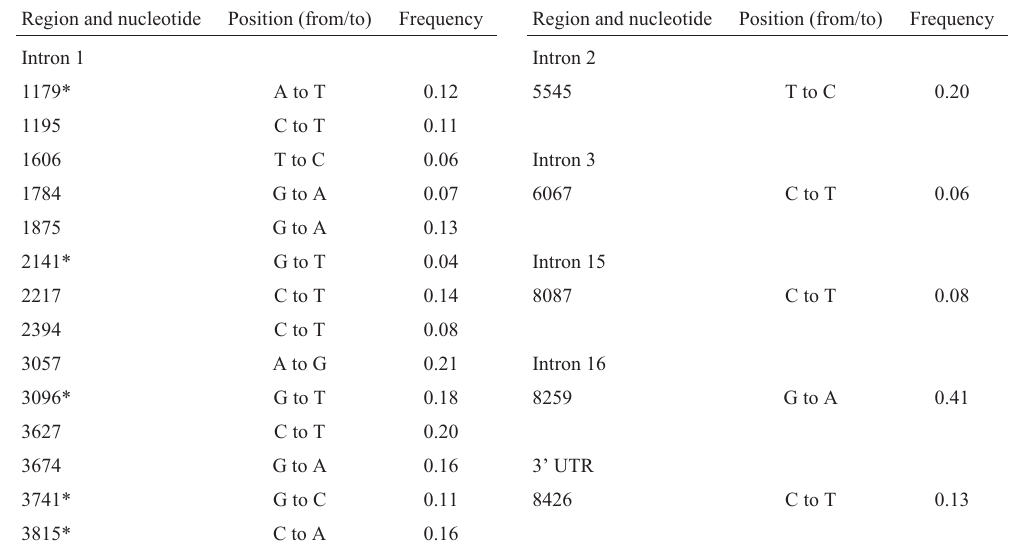
Table 3 - The DGAT1 polymorphism in Indian buffalo ( Bubalus bubalis ) breeds. Data shown for introns and the 3’ untranslated region (UTR). Region and